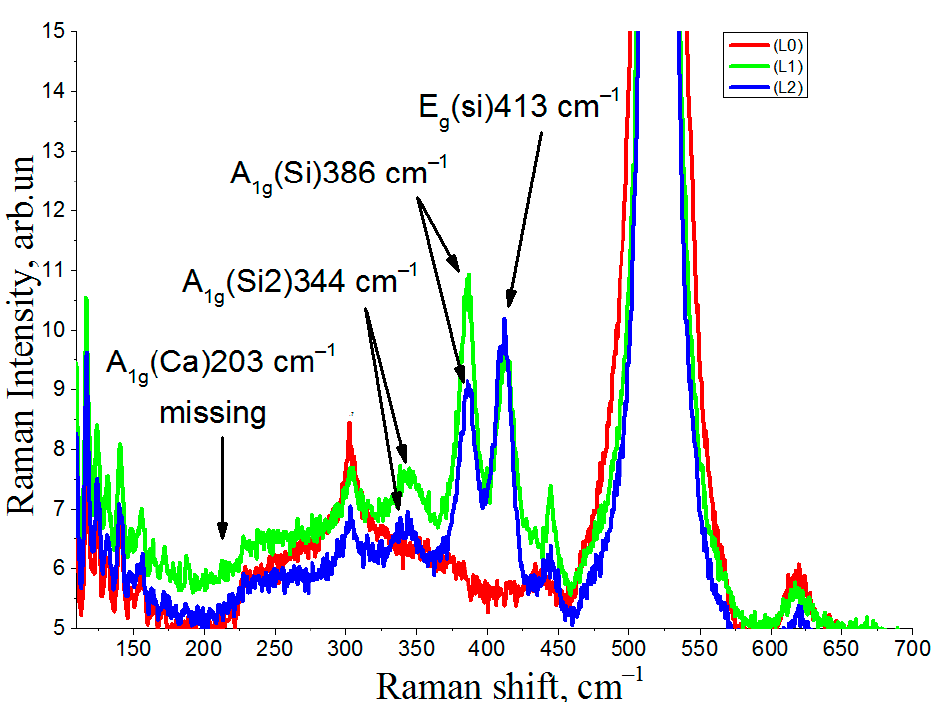
Figure 2. Raman scattering spectra: L0—in the non-irradiated region, L1—irradiation of CaF 2 during growth, L2—irradiation of CaF 2 after growth.